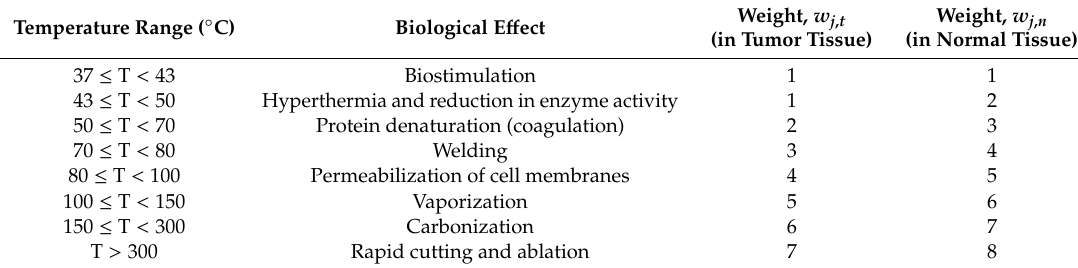
Table 1. Laser-induced thermal e ff ects